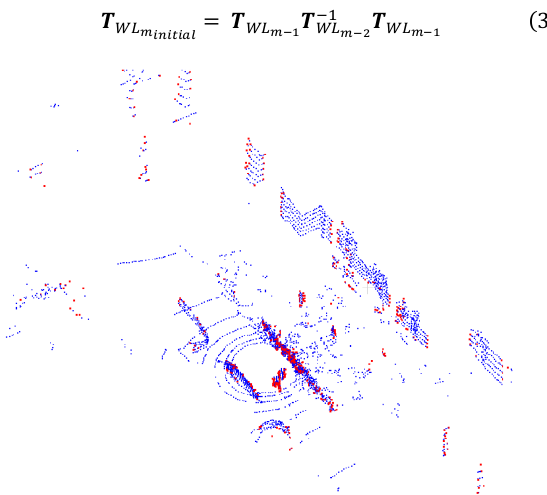
Figure 2. low level feature extraction (edge points in red and planar in